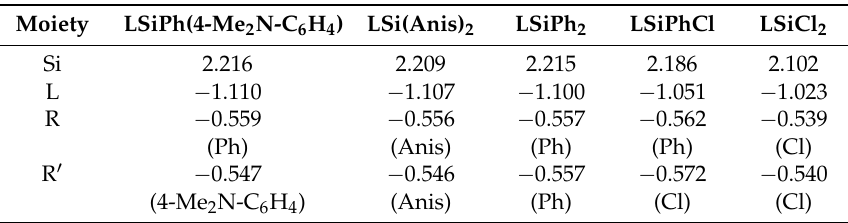
Table 4. Natural Charges (NCs) of ligand L, Si and the monodentate substituents of the hexacoordinate Si complexes discussed in this